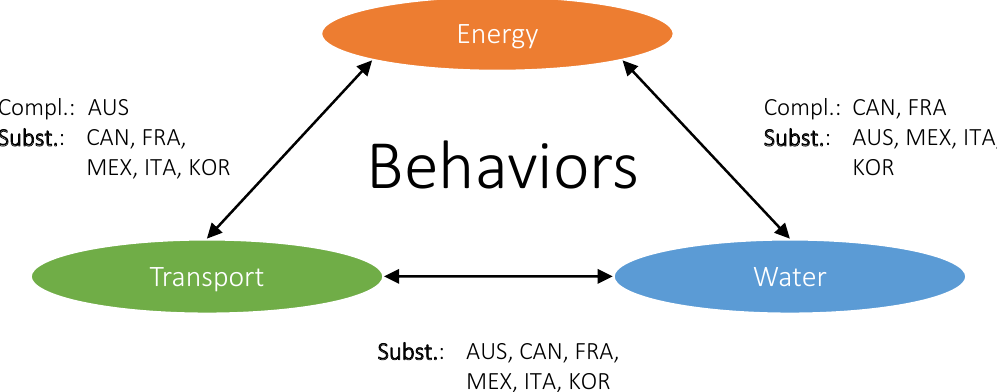
Figure 3. Summary of the relation of behaviors in the domains energy, transport and water in six countries. In bold is the dominating relation